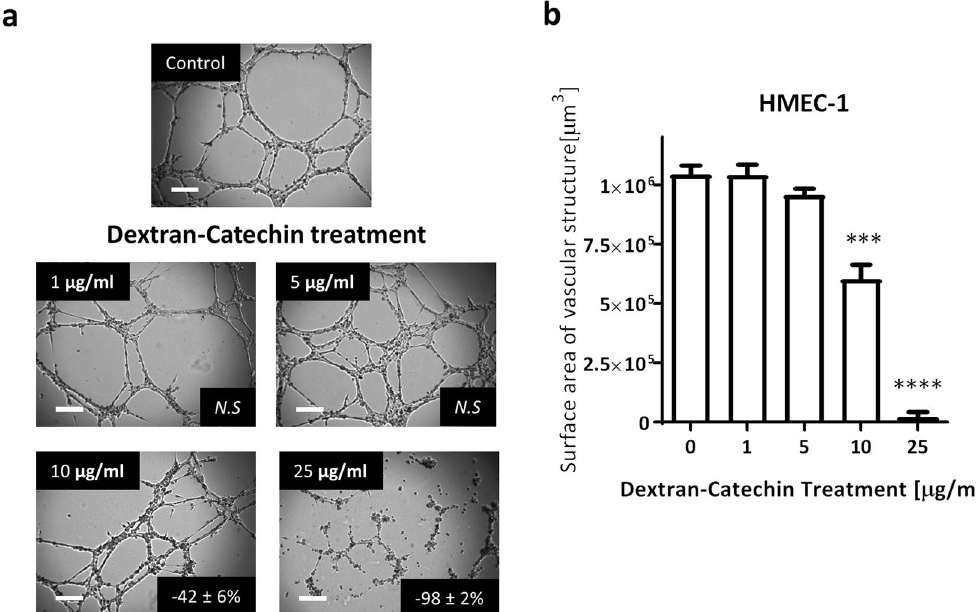
Figure 1. Effects of Dextran-Catechin treatment on HMEC-1 angiogenic activity. ( a ) Representative photographs of HMEC-1 cells in Matrigel ™ assays following 8 h Dextran-Catechin treatment. Inset , % of inhibition as compared to untreated control cells; N.S . non-significant; Scale bar 200 µ M. ( b ) Total surface area of vascular structure measured. Columns, n = 3; bars, SEM ( *** p < 0.001, **** p <